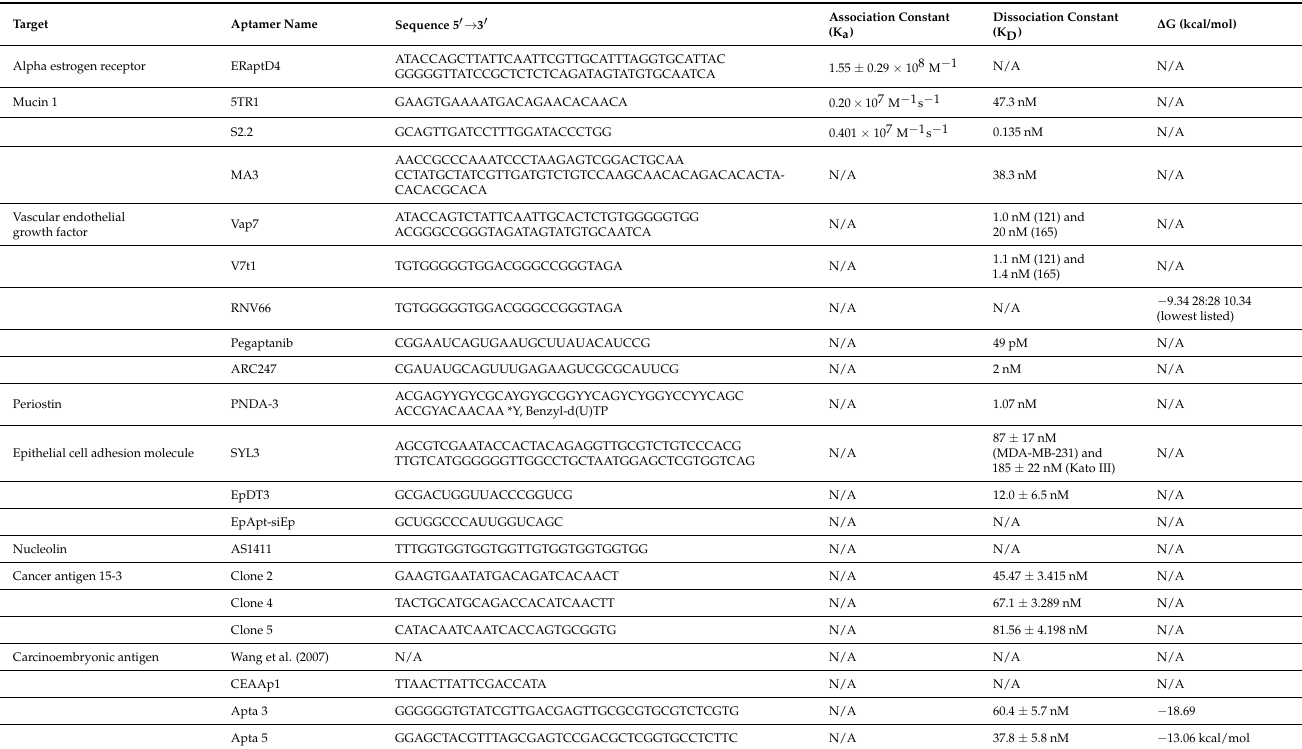
Table 2. Summary of the known breast cancer targets, available aptamers for targeting biomarkers, the binding constants, and respective Gibbs free